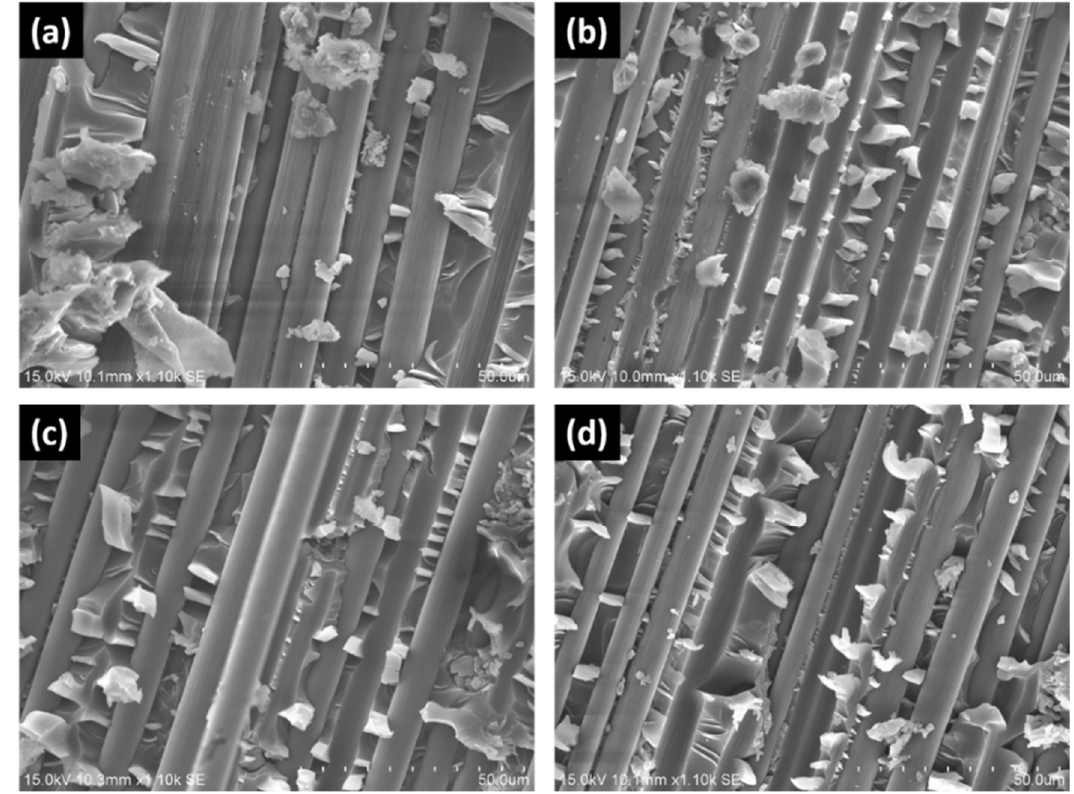
Figure 5. Scanning electron micrographs of the ENF specimens at ( a ) 1, ( b ) 10, ( c ) 100, and ( d ) 500 mm/min.